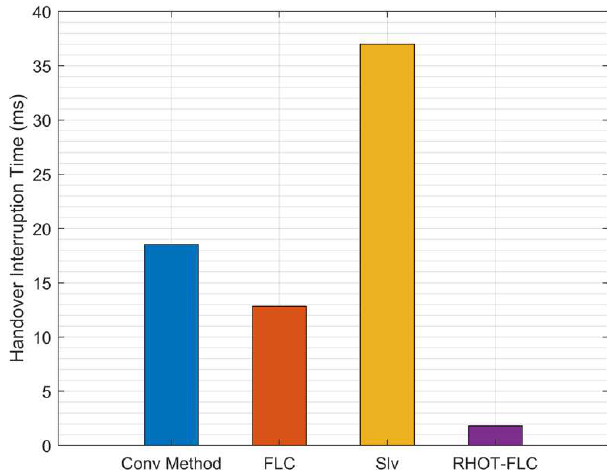
Figure 11. Average HIT overall mobile speeds scenarios.